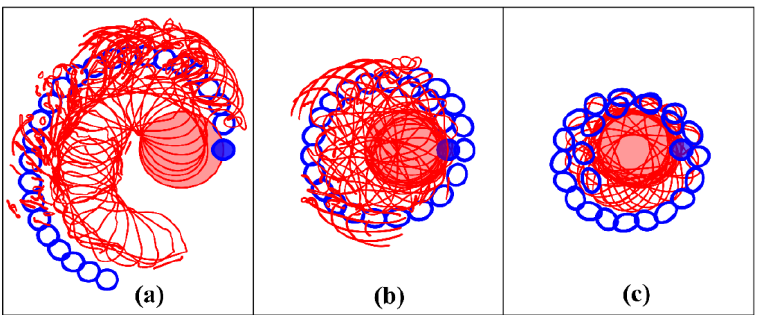
Figure 7. Motion of a two-layer heton (vertical dipolar vortex), with the same parameters r 1 , r 2 , P 1 , P 2 , as in Figure 6, but with L = 4 at the indicated dimensionless times.